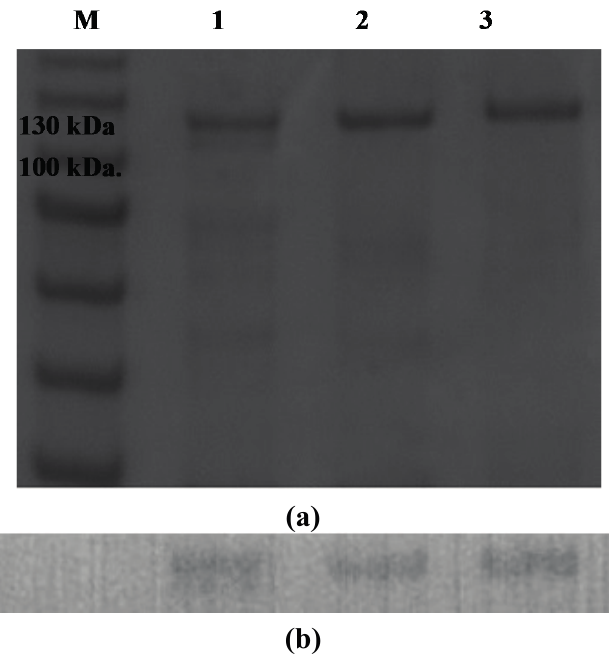
Figure 4. The ( a ) SDS-PAGE and ( b ) Western blot of AgaA. Lane M , protein marker; Lane 1 , AgaA-FL; Lane 2 , AgaA- Δ SP; Lane 3 ,